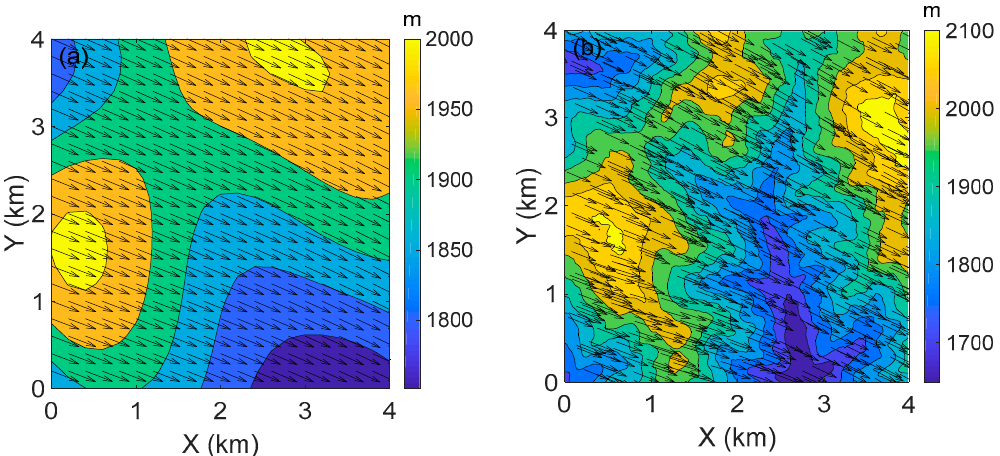
Figure 15. Topography (m) and wind vectors (m / s) at 800 m, 16:00 on 21 May 2018: ( a ) WRF simulation; ( b ) WRF ‐ CFD simulation.